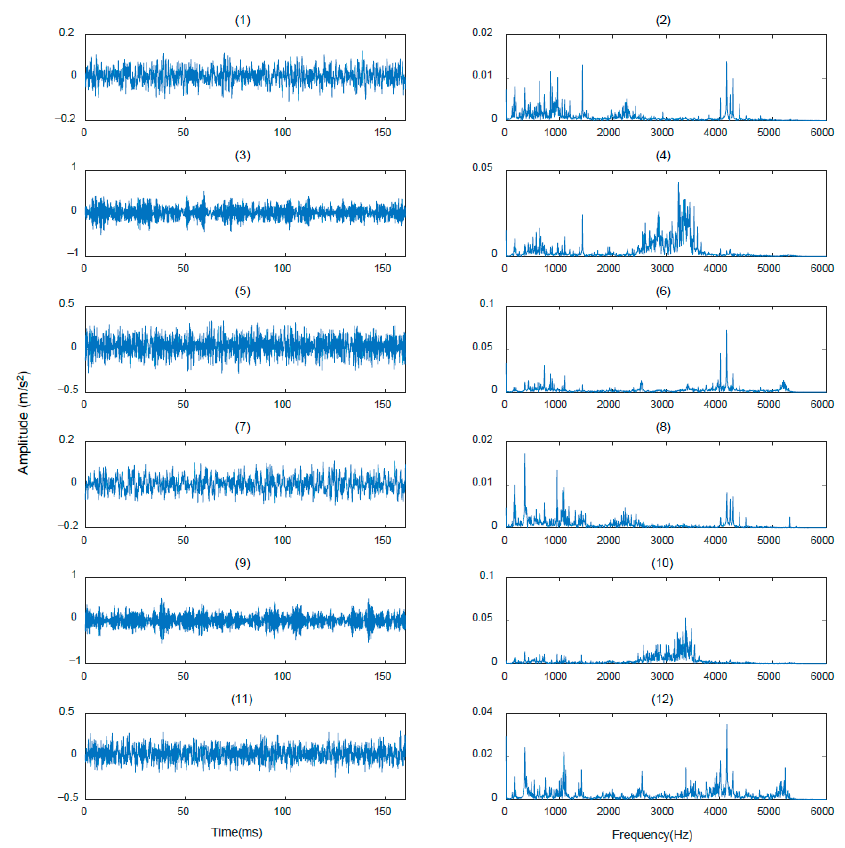
Figure 7. Visualization of a part of training